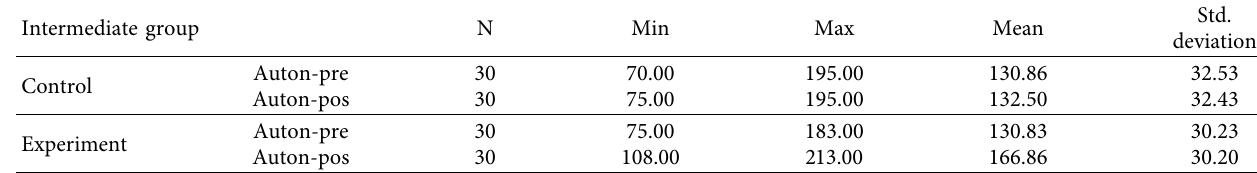
Table 1: Descriptive statistics in upper-intermediate groups.